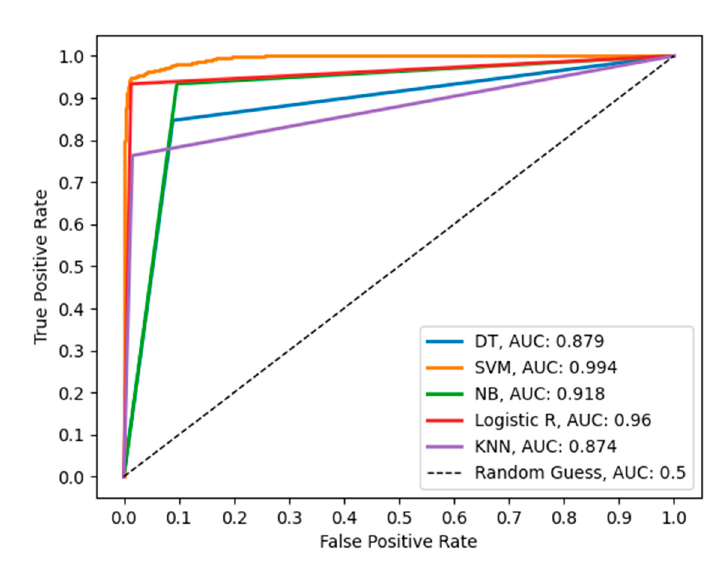
Figure 9. ROC comparing performances of the classifiers using 4096 FC2 features of the VGG16 model.